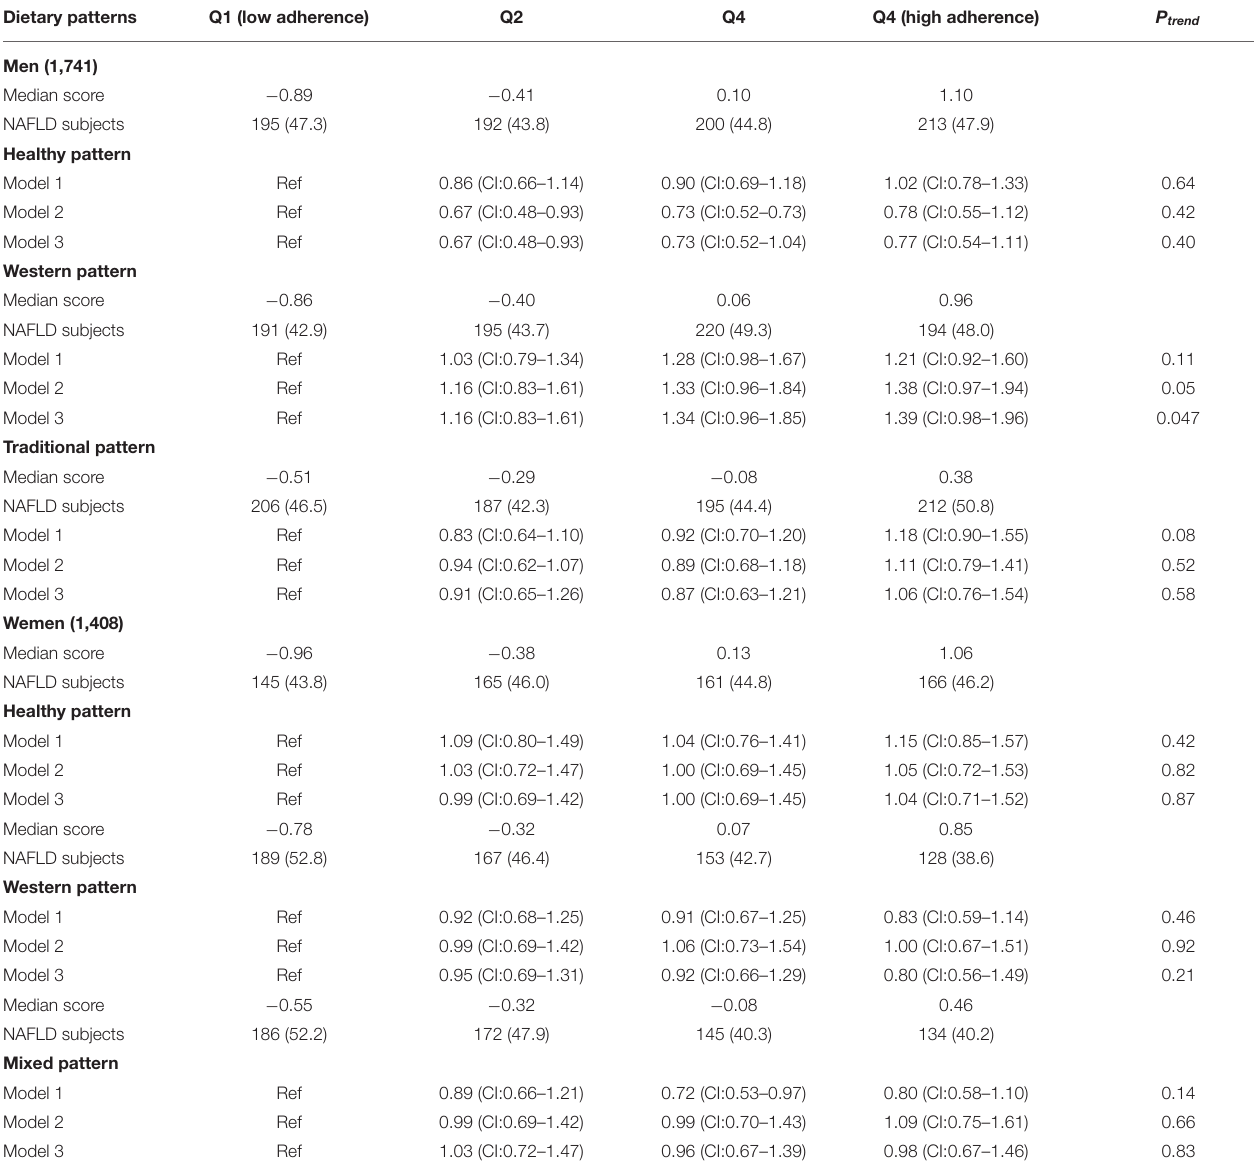
TABLE 4 | Odds ratios (95% CI) for NAFLD across Quartiles (Q) of dietary pattern scores. Dietary